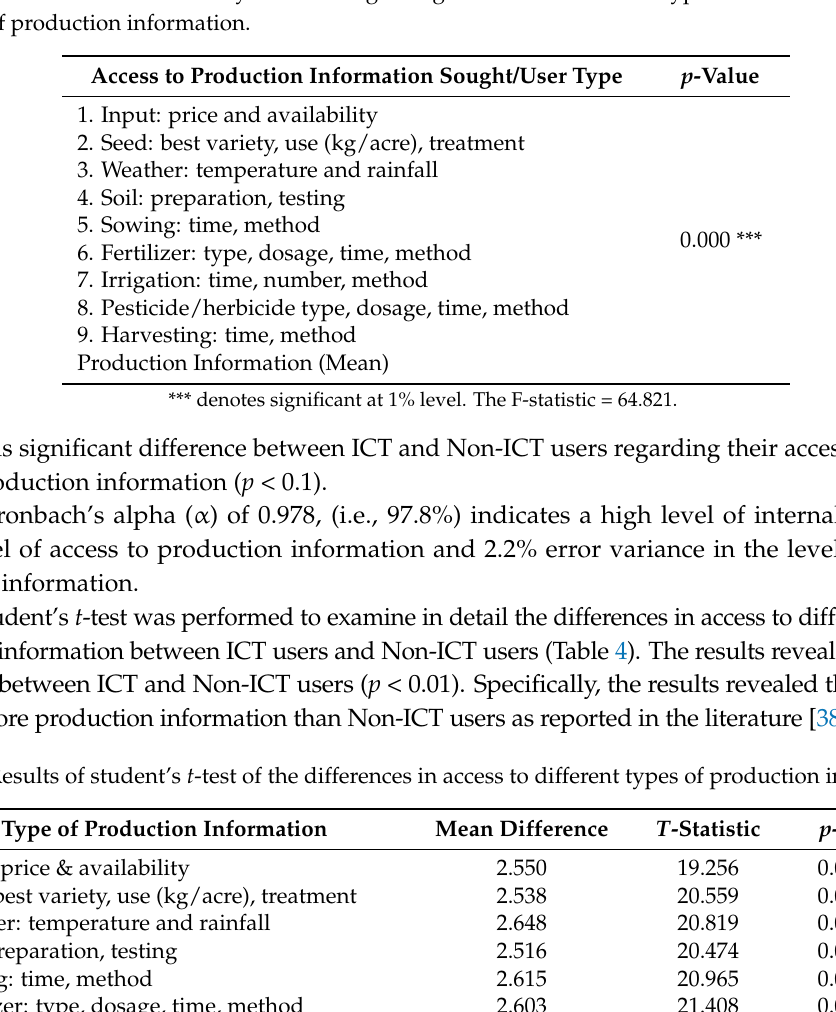
Table 3. Results of the One-way ANOVA regarding the influence of user type on access to different types of production information.